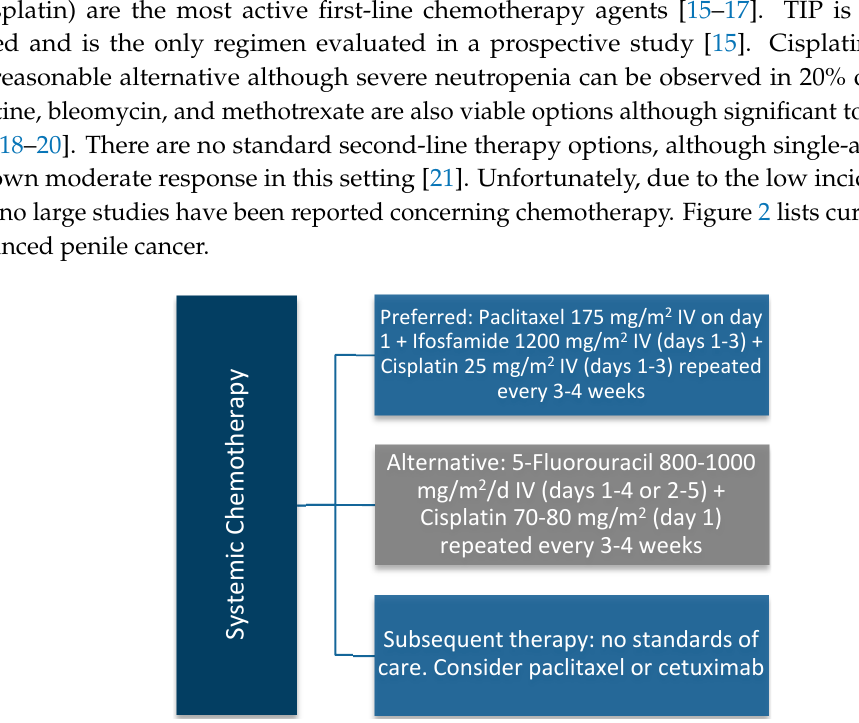
Figure 2. Current regimens in metastatic penile cancer.